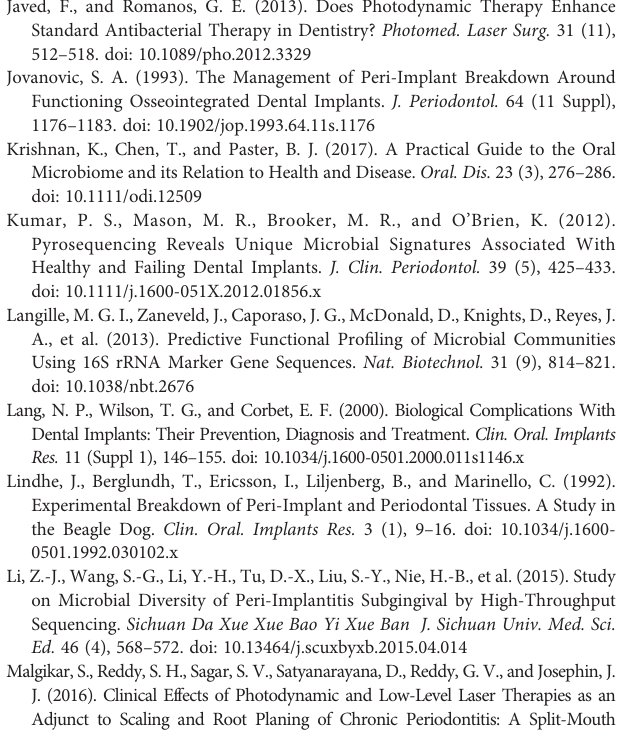
Supplementary Table S5 | The signi fi cant difference pathways in the KEGG level 3 between different time points. Supplementary Figure S1 | Rarefaction curves of the numbers of reads from the GCF samples of 6 time points. Supplementary Figure S2 | The beta diversity of the GCF microbiota over time. The bray-curtis distance compared between microbiota of each time point and pre. Signi fi cance was measured using Wilcoxon rank-sum test ( P >0.05, ns). Supplementary Figure S3 | Taxonomic LEfSe plot obtained using linear discriminant analysis (LDA) effect size (LEfSe) analysis. LEfSe identi fi ed the taxa with the greatestdifferencesinabundancebetweenthe180daysafter-treatmentgroupandpre- treatment group. Only taxa meeting a signi fi cant LDA threshold value of >2 are shown. Supplementary Figure S4 | The relative abundance of Lactobacillus , Bulleidia , Peptoniphilus , and Anaeroglobus over time. Supplementary Figure S5 | The relative abundance of each predicted functional category given in the KEGG pathways (level 3). The functional pathway compared betweeneachtimepointandpre.Signi fi cancewasmeasuredusingWilcoxonrank-sum test ( P <0.05, **). Only statistic signi fi cant pathways are shown. Day0: before